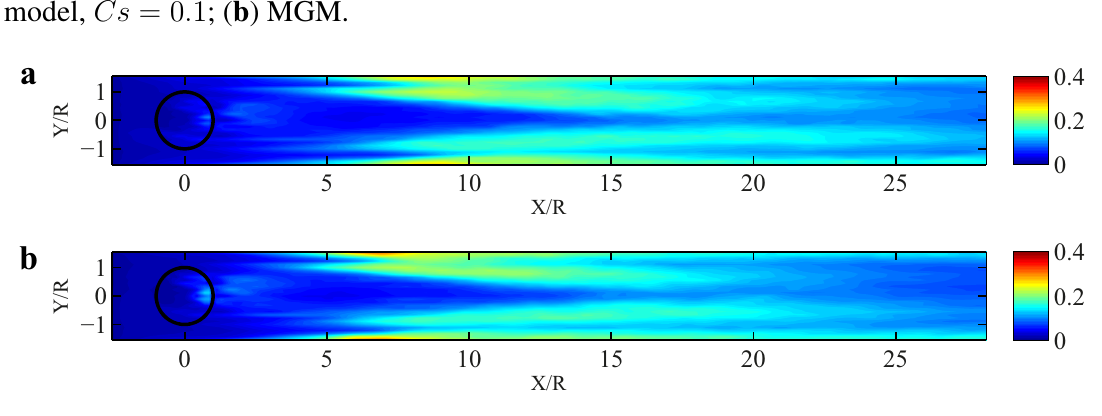
Figure 13. Contours of the normalized mean streamwise turbulence intensity (resolved part), σ /U , in a horizontal plane at the equator height of the rotor for the ALM: ( a ) Smagorinsky u 0 model, Cs = 0 . 2 ; ( b ) Smagorinsky model, Cs = 0 . 1 ; ( c )